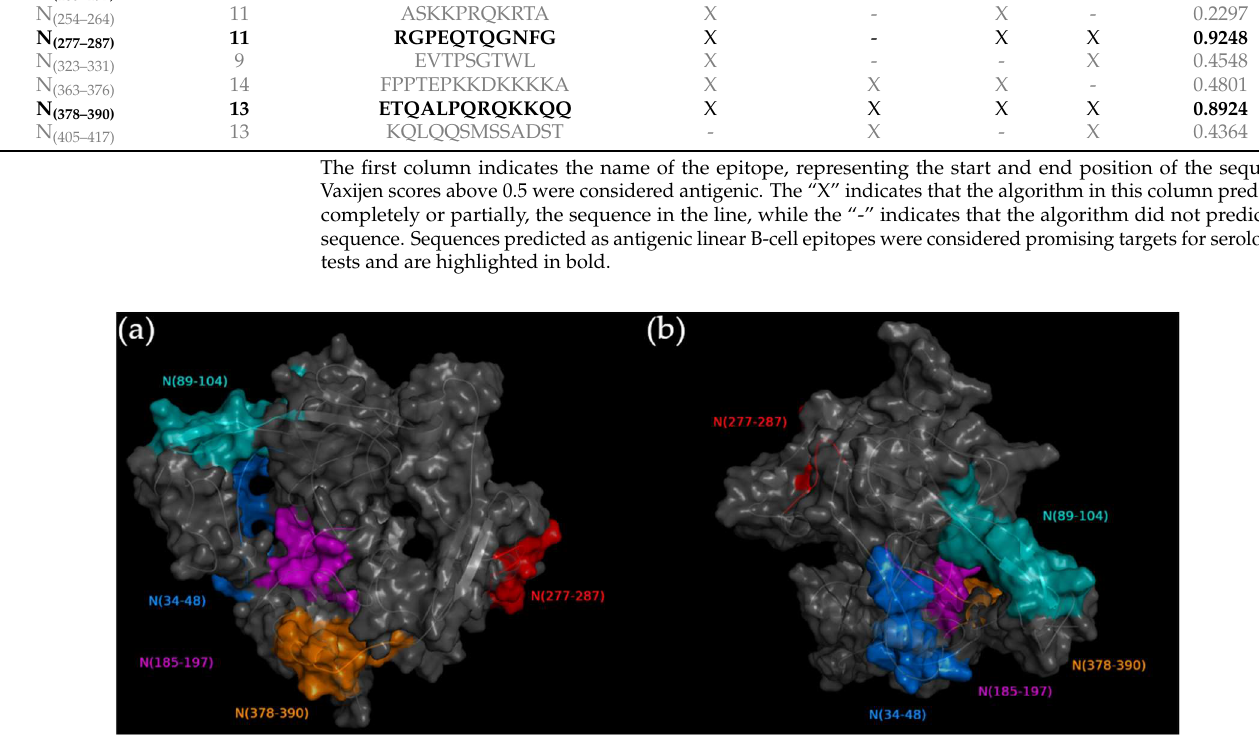
Figure 1. Location of predicted epitopes in SARS-CoV-2 N protein 3D structure. The protein chain is indicated by a gray cartoon and transparent surface. The locations of epitopes N (34–48) , N (89–104) , N (185–197) , N (277–287), and N (378–390) were indicated by colors blue, teal, purple, red, and orange, respectively. In the cartoon, round helices, flat sheets, and smooth loops are applied to allow better visualization of the predicted structure. Different rotations of the protein are shown in ( a ) and ( b